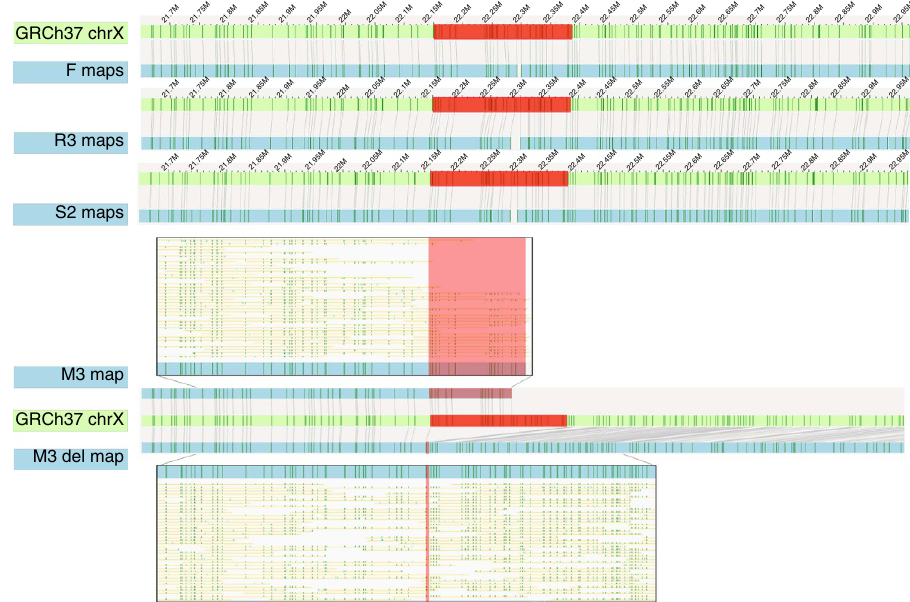
Figure 3 | A 228.8-kb deletion at Xp22.11 in sample M3 detected by BioNano genome mapping. Each assembly is compared with the GRCh37 reference genome. Black vertical marks show the position of the fluorescently labelled seven-base motif. For the M3 sample, observed individual DNA molecules and their labels are represented, showing the support for two haplotypes, one with the deletion at